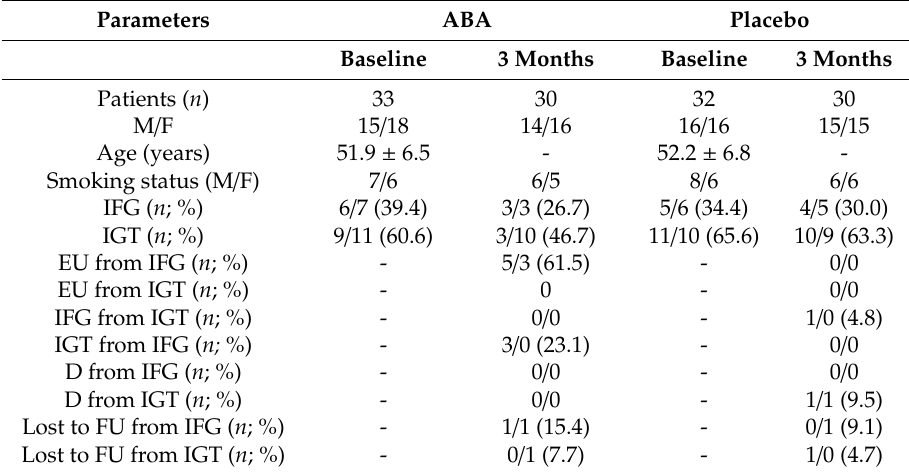
Table 2. Baseline, and 3-month anthropometric and biochemical parameters of patients during abscisic acid (ABA) treatment and